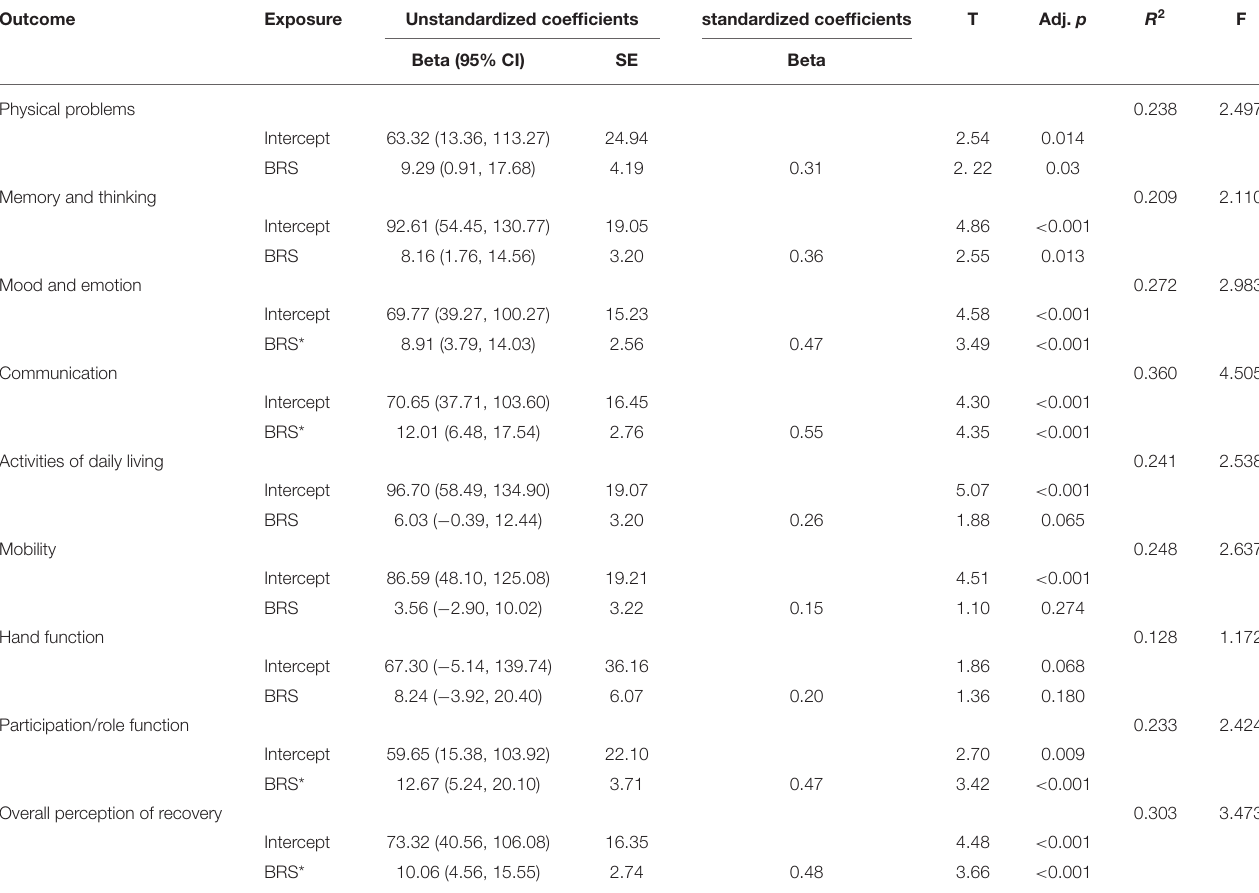
TABLE 5 | Main effect of resilience (BRS) on Stroke Impact Scale